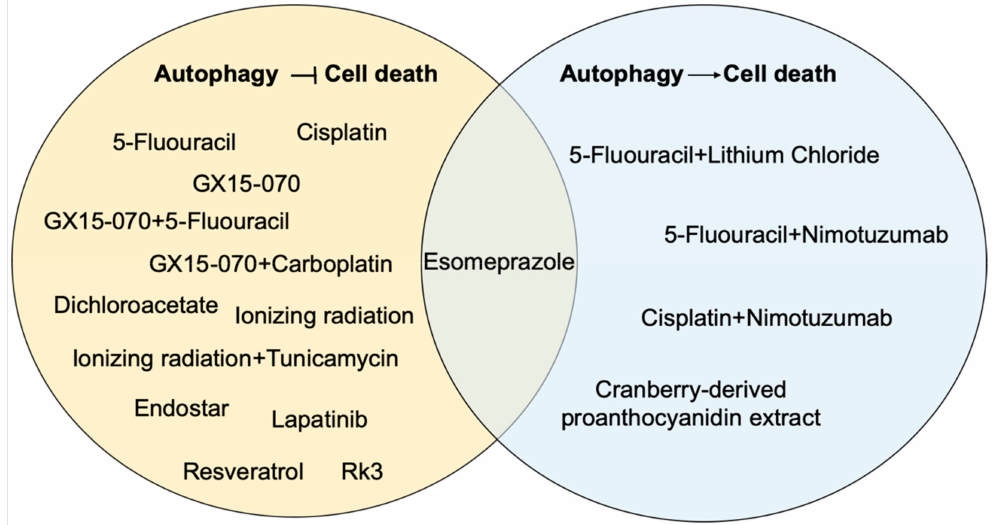
Figure 3. Summary of studies investigating e ff ects of autophagy on therapeutic response in esophageal cancer. Therapeutic interventions that activate autophagy to limit cell death are shown in the yellow circle, while therapies that activate autophagy to promote cell death are shown in the blue circle. Esomeprazole is present in the overlapping space between the two circles as it has been shown to activate autophagy to limit cell death and also promote cell death in a context-dependent